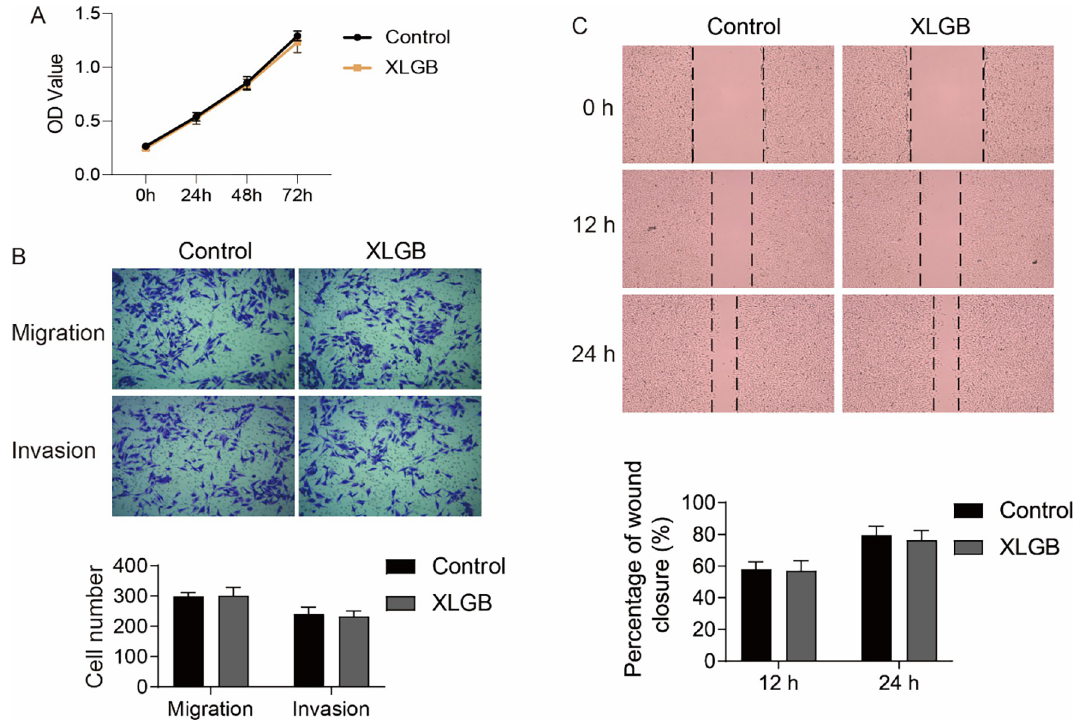
Fig 6. Effects of XLGB overexpression on the proliferation, migration and invasion of MG63 cells under conventional culture conditions. A. The proliferation was determined by CCK8 assay in control and XLGB overexpressed MG63 cells. B. Wound-healing assay was performed to detect cell migration. C. Transwell assay was performed to detect the migration and invasion of MG63 cells. Data represented mean ± SD of three separate experiments.